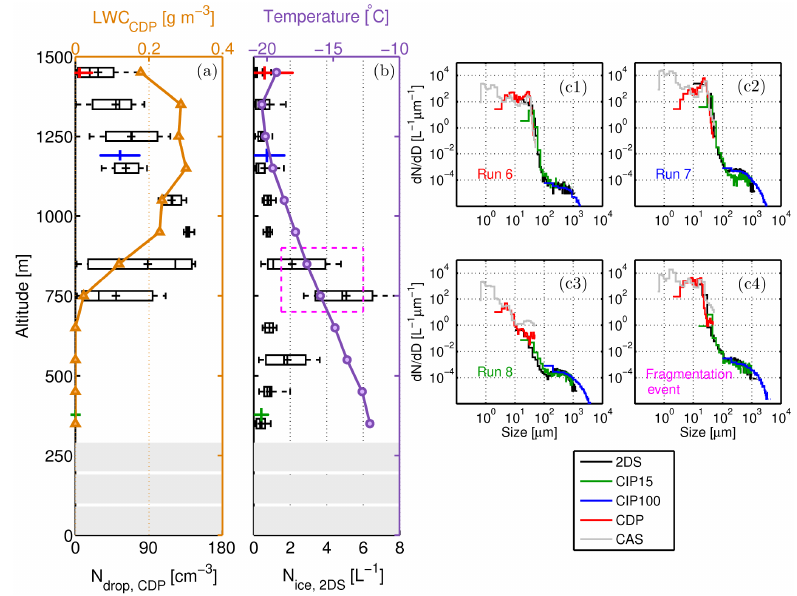
Figure 9. Microphysics summary of averaged observations over the ocean. Data are displayed similarly to Fig. 6. In (a, b) , data from each SLR are again shown in colour at each corresponding altitude (run 6: red, run 7: blue, run 8: green) as before. (c1–4) Number size distributions (d N/ d D ) from each SLR over the ocean (runs 6–8). Legend refers to (c) only. High ice number concentrations at cloud base are labelled as a fragmentation event (see Sects. 4.1.2 and 5.3).